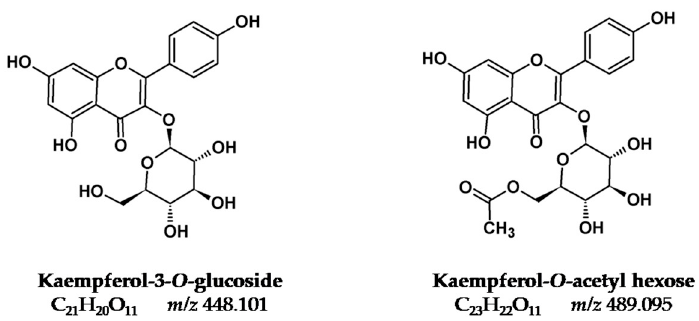
Figure 3. Kaempferol-based chromophores (flavonols).